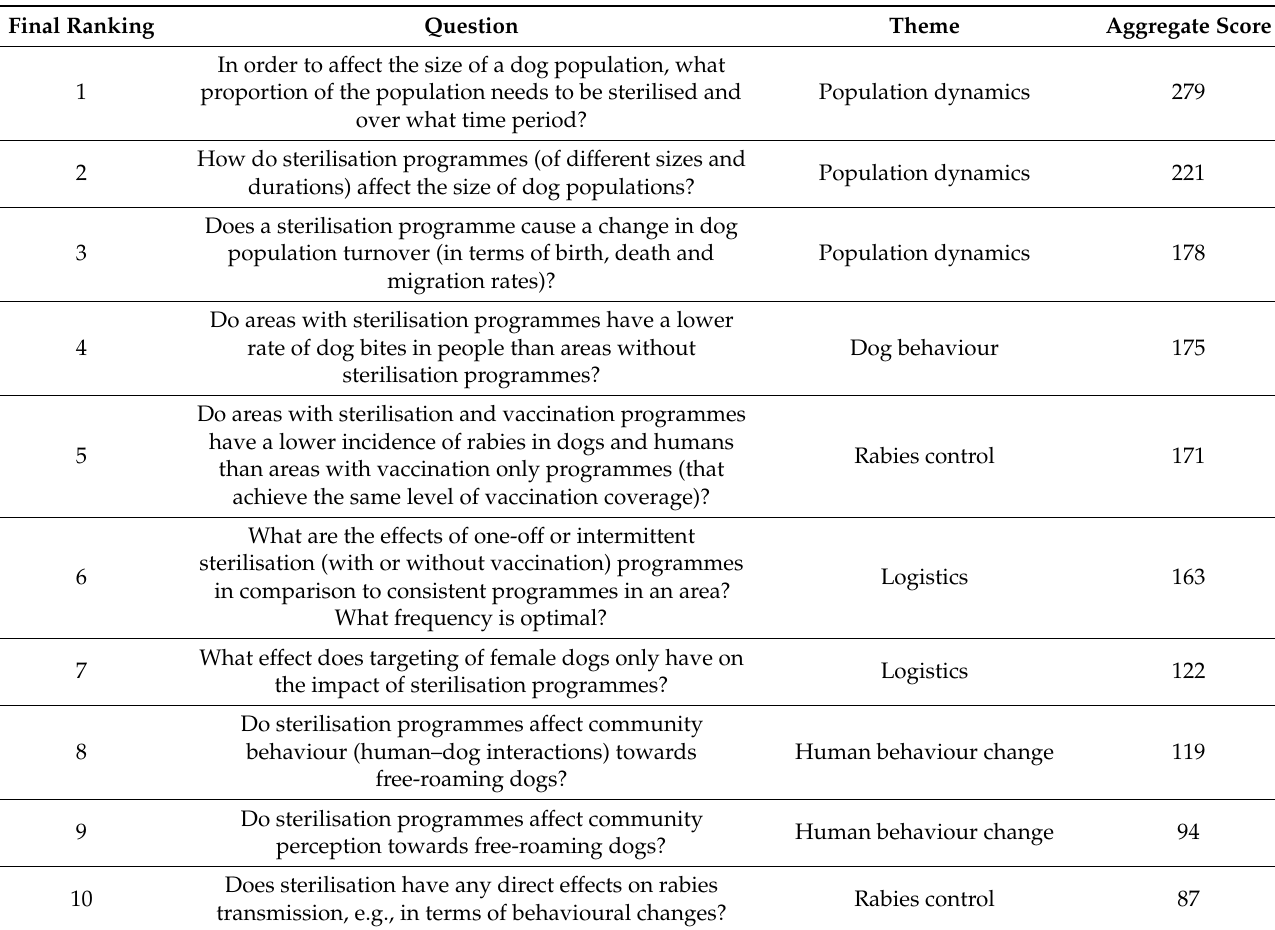
Table 3. Top 10 research priorities as a result of a James Lind Alliance Priority Setting Partnership and Delphi panel. Final